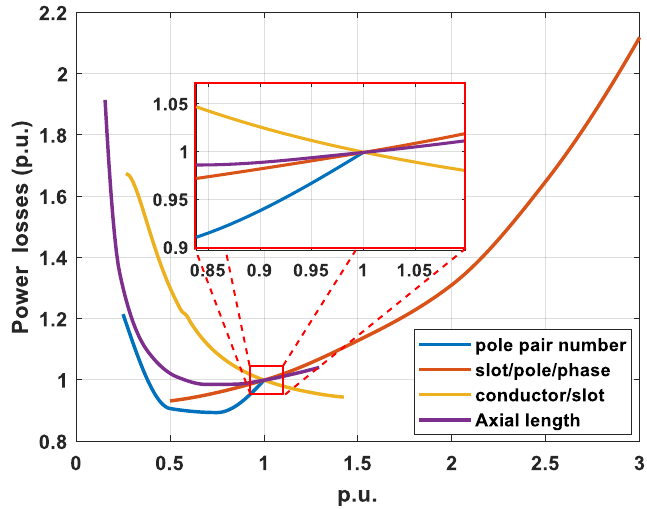
Figure 7. Effect of the input parameters on the total power losses.